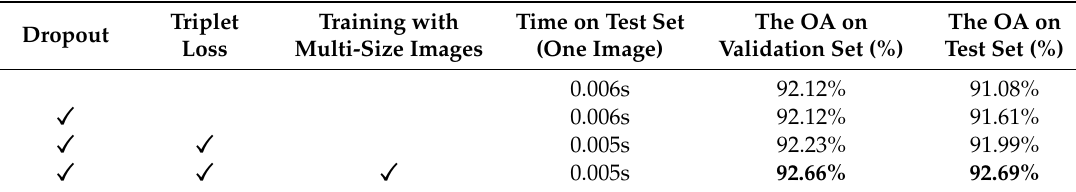
Table 5. The results of ablation